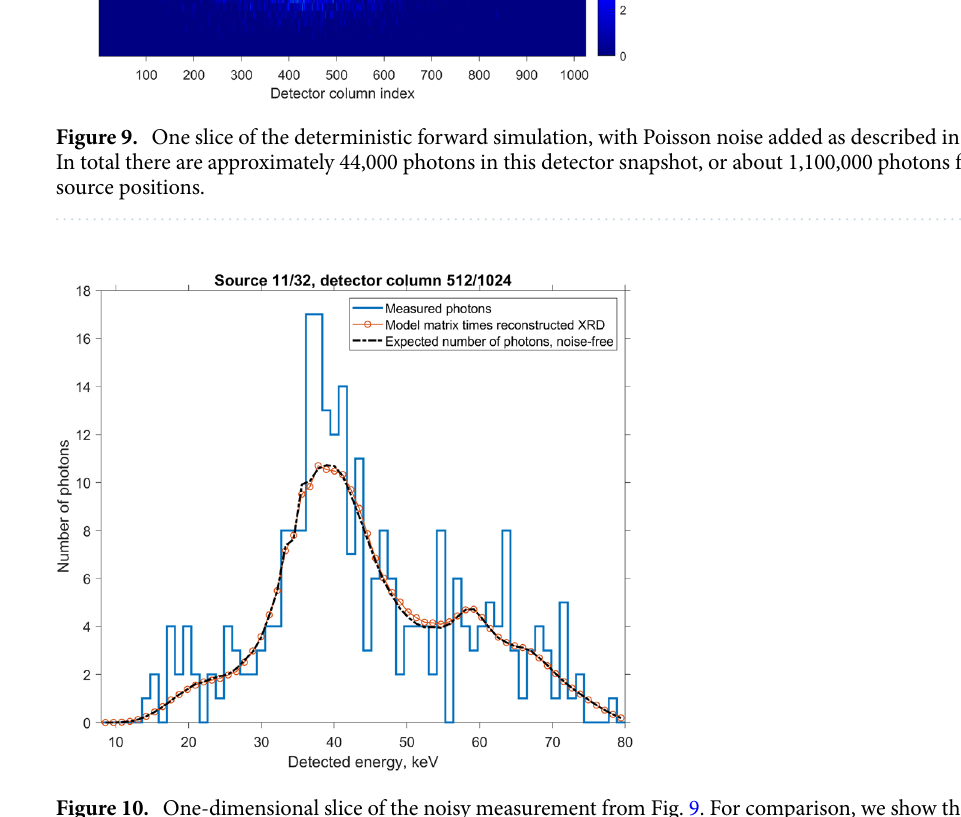
Figure 10. One-dimensional slice of the noisy measurement from Fig. 9. For comparison, we show the number A F bias , computed using the reconstructed F , as well as the noise-free ground truth of photons N = · + calculation for the number of photons, Eq.